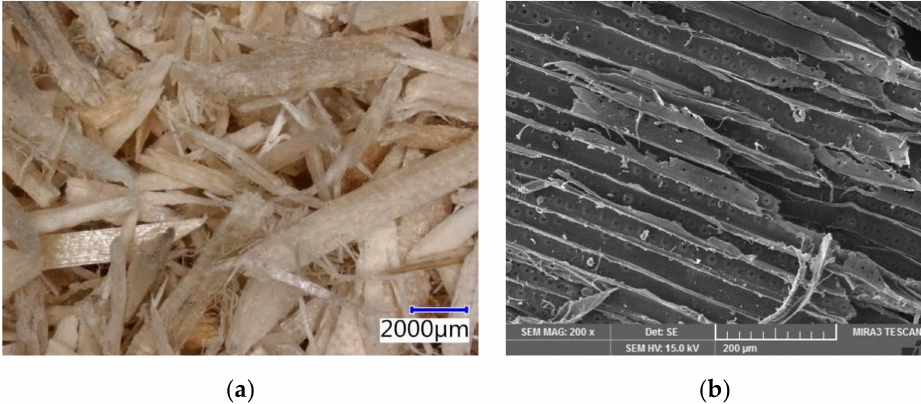
Figure 2. Spruce chips used in cement-bonded particleboard production—pictures from Keyence VHX-950F optical microscope and Tescan MIRA3 XMU scanning electron microscope: ( a ) structure of chips—optical microscope; ( b ) structure of spruce chips in detail—SEM.